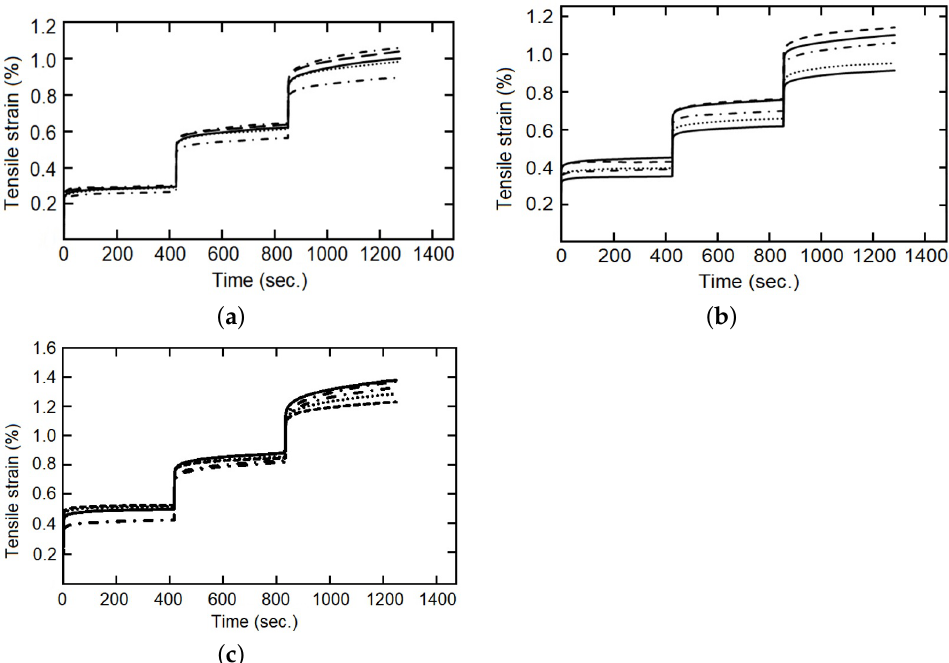
Figure 6. Fluency staggered test, five specimens, ( a ) with 9 wt%, ( b ) with 14 wt%, and ( c ) with 28